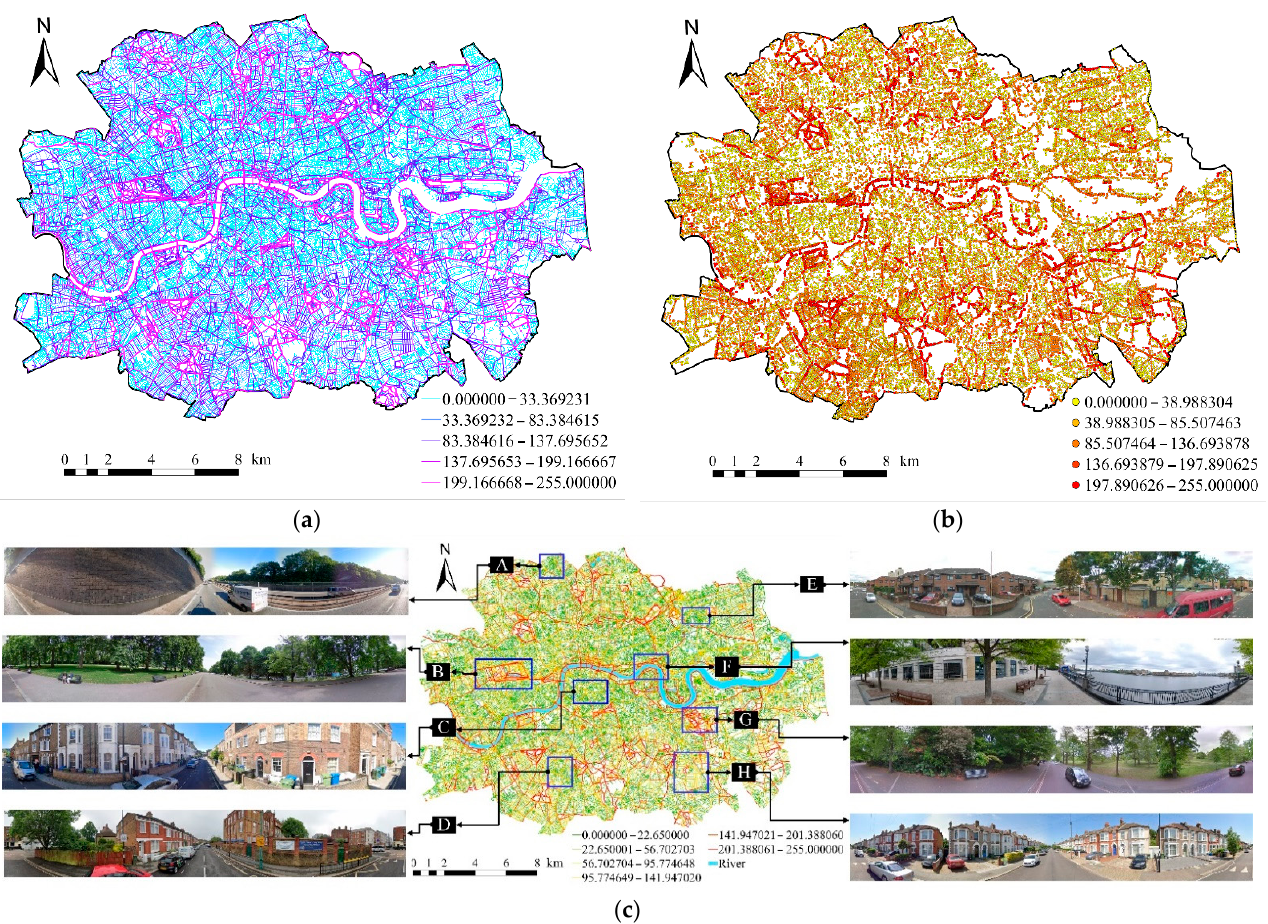
Figure 6. The value of the running amount and the spatial distribution of 40,290 sample points. ( a ) The raster value in the OSM street networks extracted from the SH in Inner London; ( b ) the spatial distribution of the running amount of 40,290 sample points; ( c ) the street scenes of some representative areas, the A–H area corresponds to a street scene, respectively.